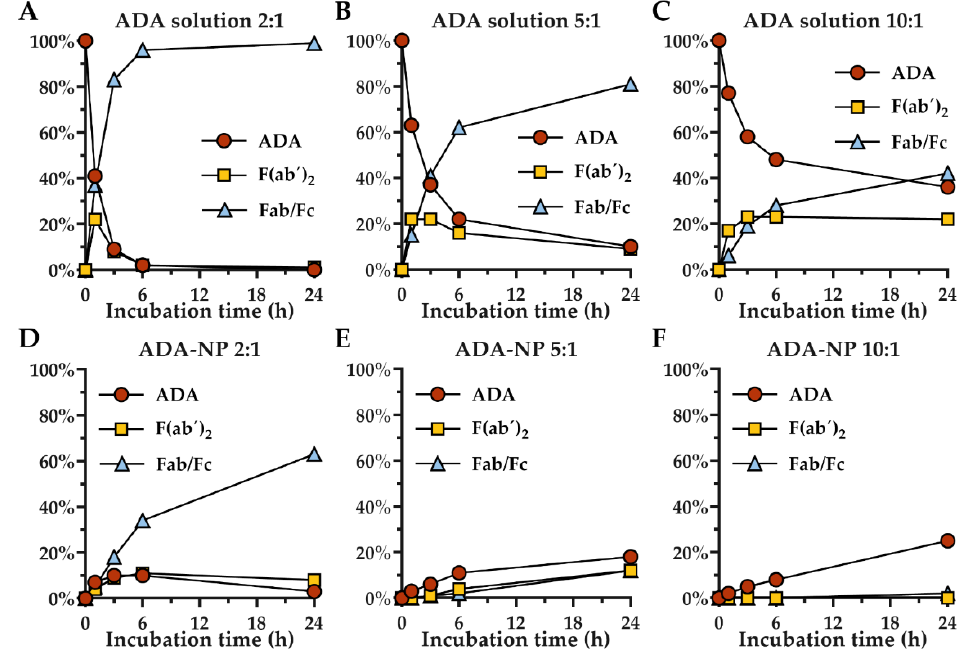
Figure 4. Impact of covalent immobilization of adalimumab (ADA) on its stability upon exposure to papain. ( A – C ) Free ADA in solution (ADA) and ( D – F ) ADA coupled nanoparticles with